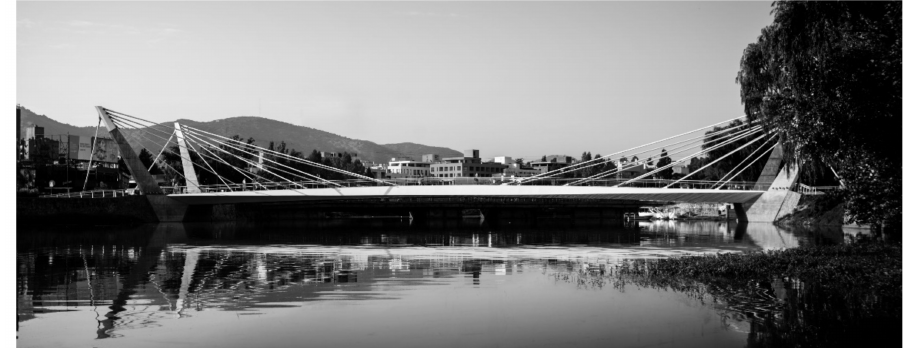
Figure 21. The completed project was inaugurated in 2020, with the ‘old bridge’ partially visible behind